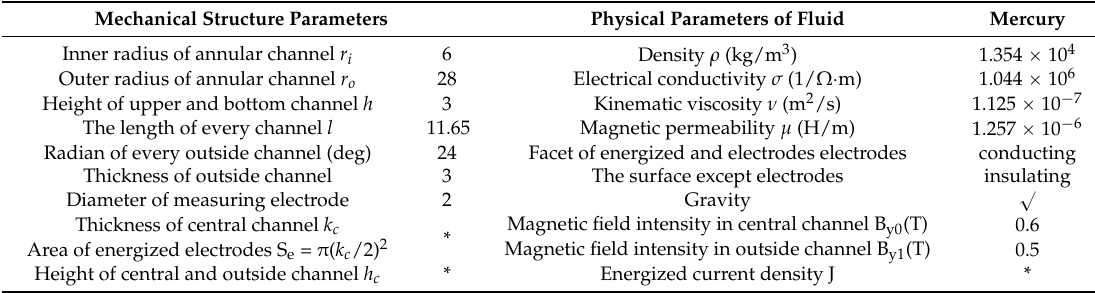
Table 1. Simulation parameters of the device to study the radial velocity generation (DRVG).